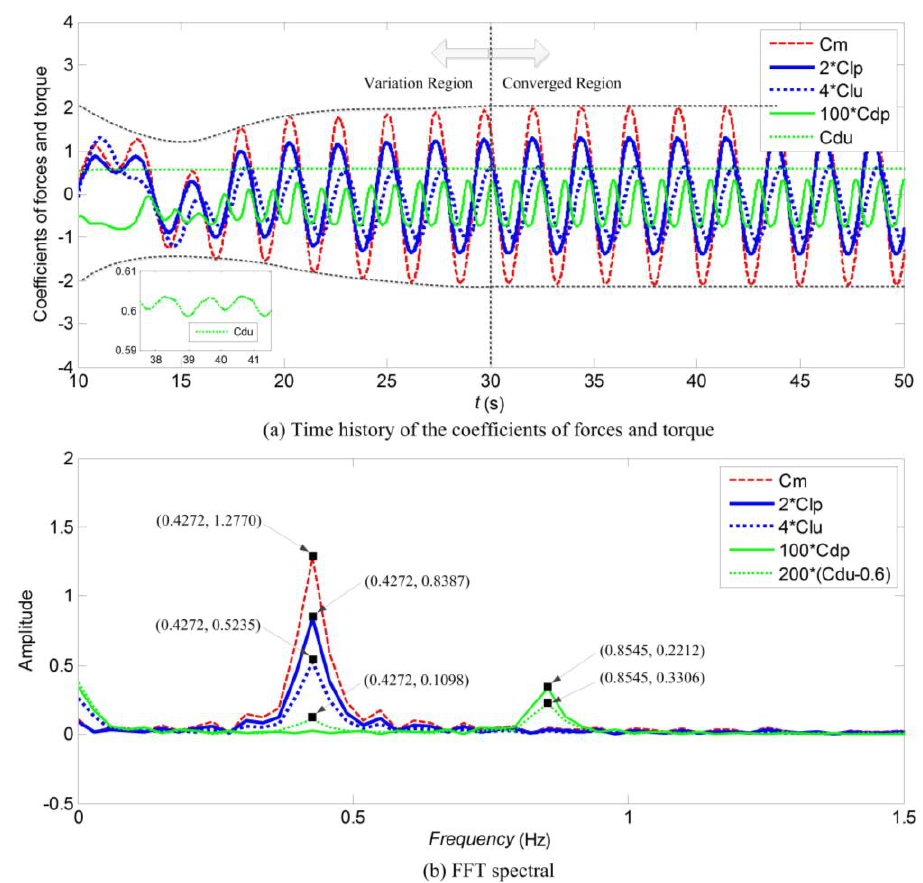
Figure 7. ( a ) Time history of the coefficients of forces; and ( b ) the frequency spectrum.